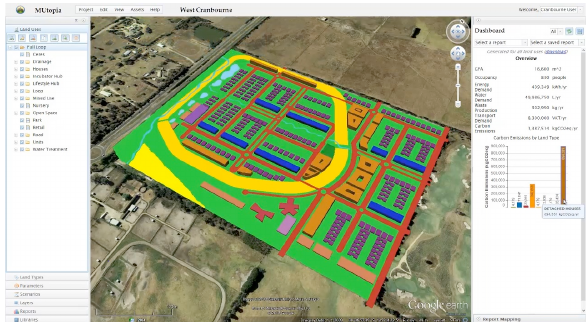
Figure 7: Prototype tool rendering of a large subdivided precinct.